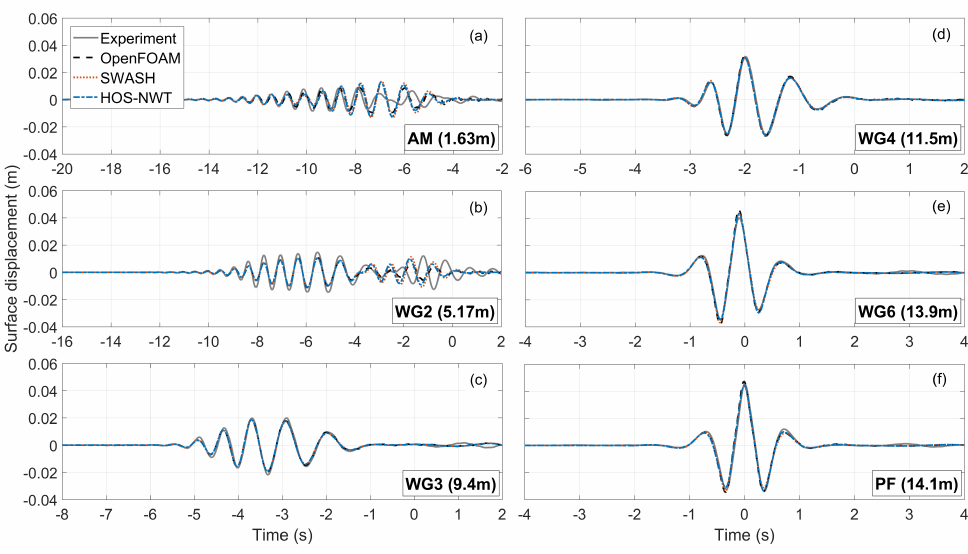
Figure 9. Comparison of the free surface elevation of the 2 nd order sum harmonics between the numerical models and the experiment at different locations ( a – f